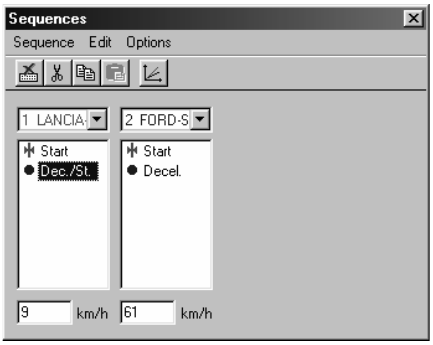
Fig 4. Insertion of the parameters of movement of the automobiles